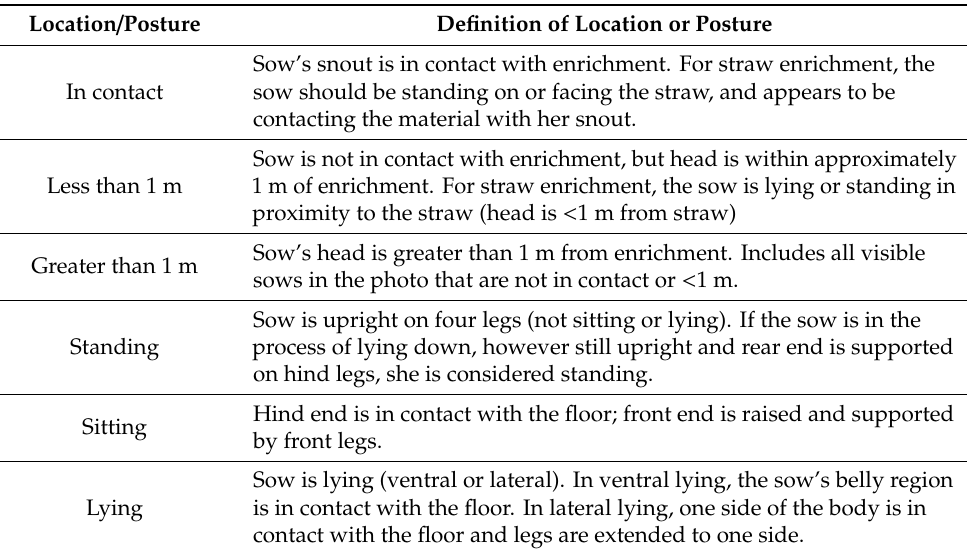
Table 1. Ethogram used to identify sow posture and location relative to enrichment.